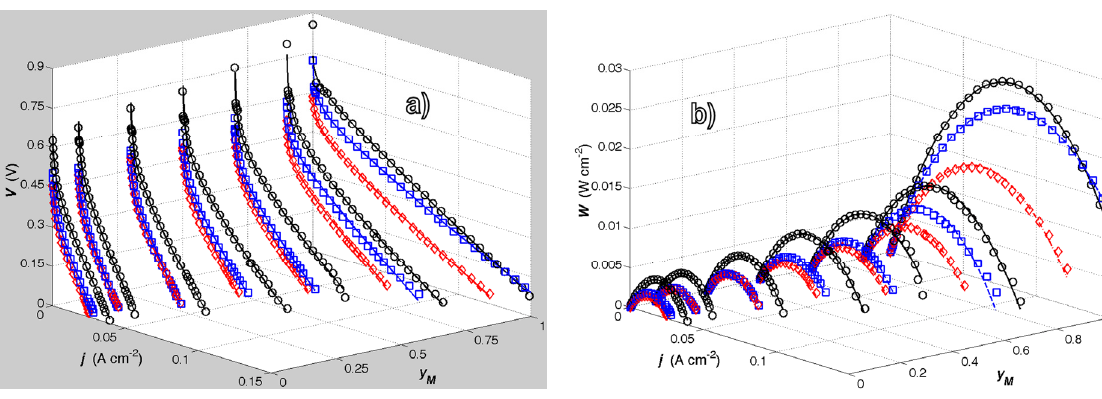
Figure 2. ( a ) (Adapted from [29]) Polarization and ( b ) power curves: experimental (bullets) and fitted (lines). ○ : first series, □ : second series, ◊ : third